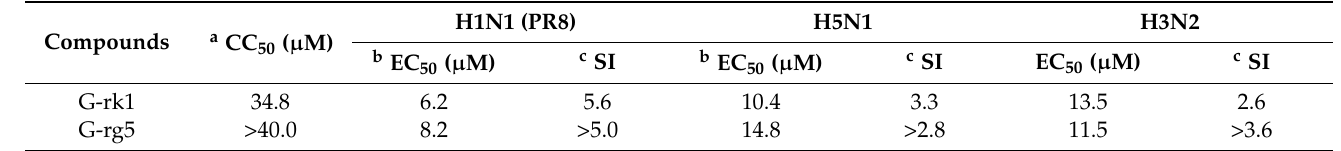
Table 1. Cellular toxicity and inhibitory effects of G-rk1 and G-rg5 against IAV in A549